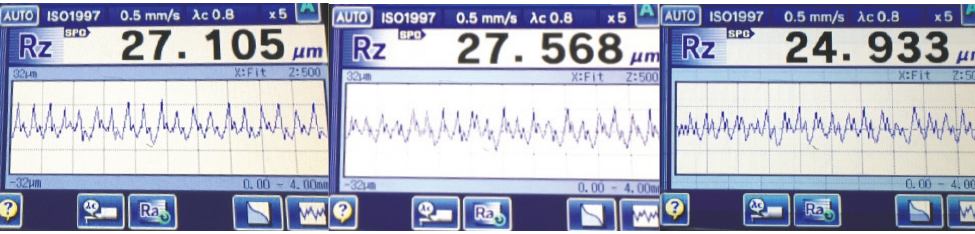
Figure 24: Pictures of Rz and profin graphs of samples 4, 5,